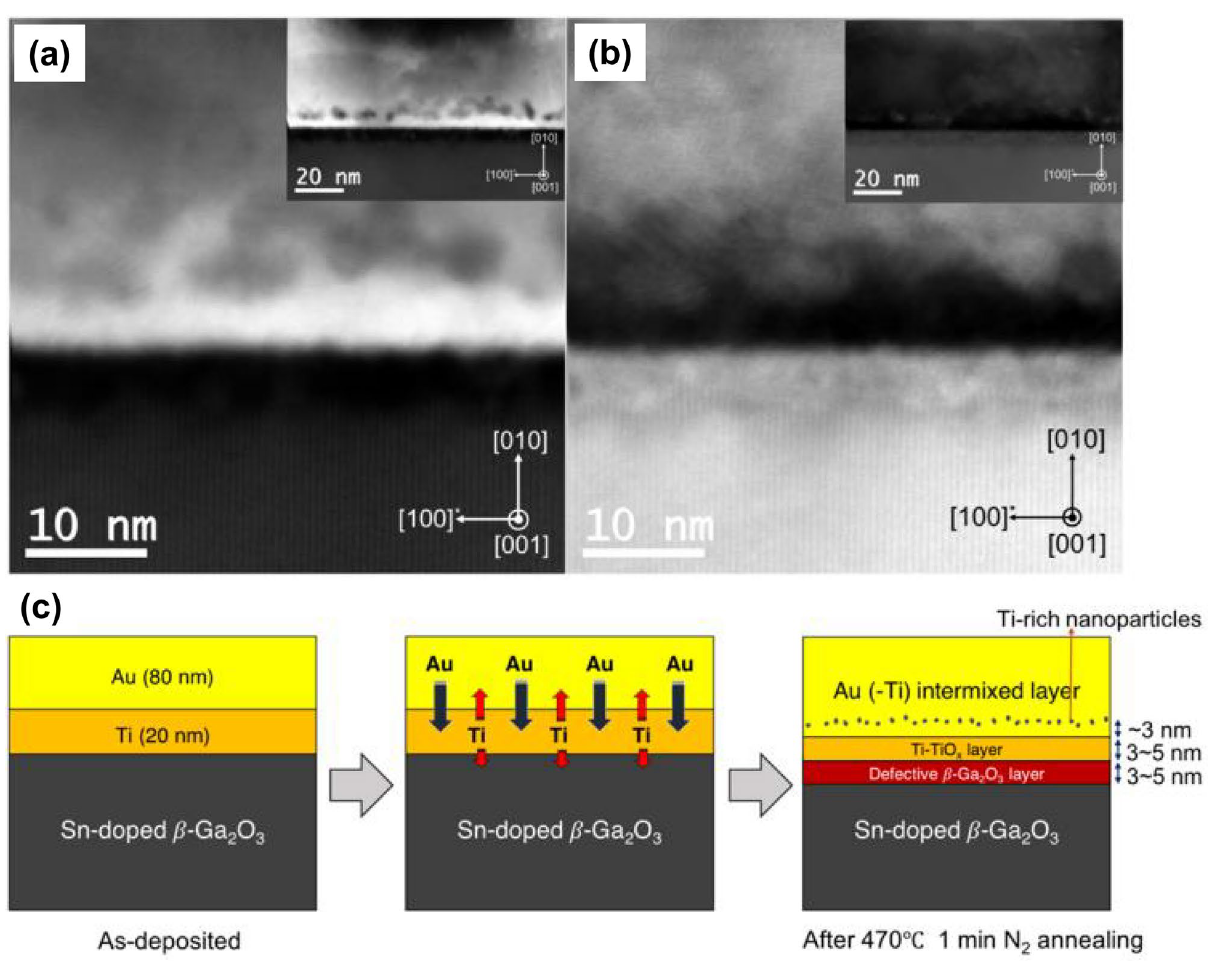
region, a Ti-TiO region, an Au rich layer, Ti- or TiO x ticles, and Au-Ti intermixed layer. c Schematic illustrations of the evaluation of the Ti/Au metallization layers on Sn-doped β -Ga by thermal annealing. (Reprinted from ref. 116, under the terms of O 2 3